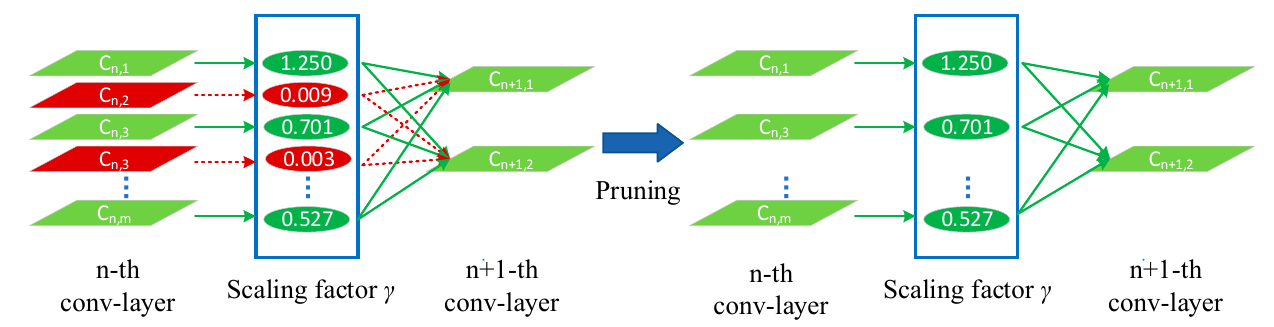
Figure 8. Pruning process.